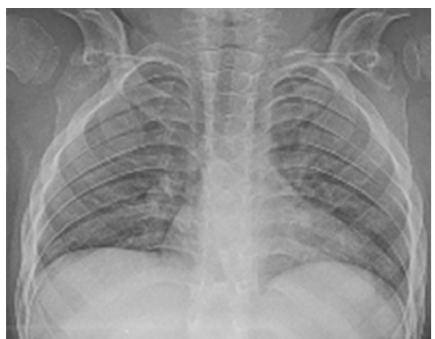
Figure 5: Chest X-ray image revealing oar-like